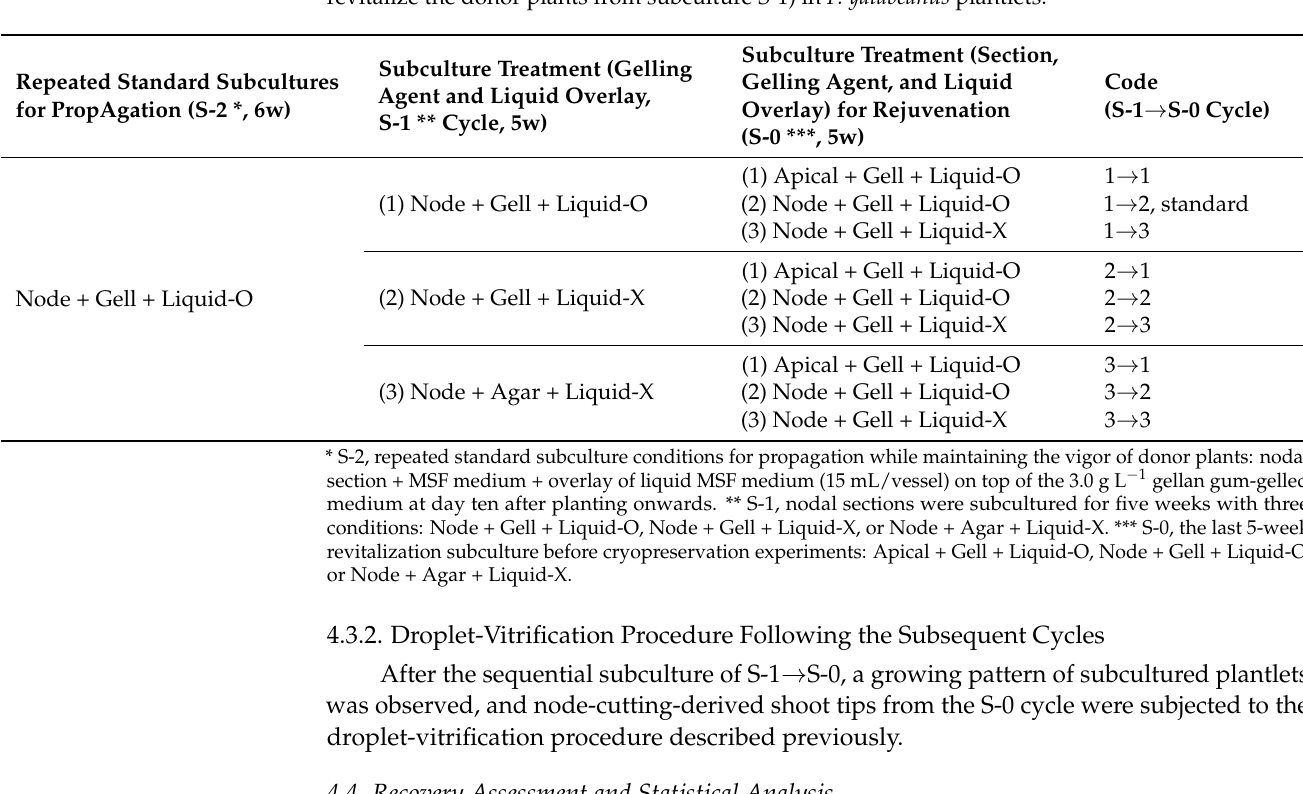
Table 4. Set of sequential subculture conditions of donor plants, i.e., S-2 (repeated subcultures